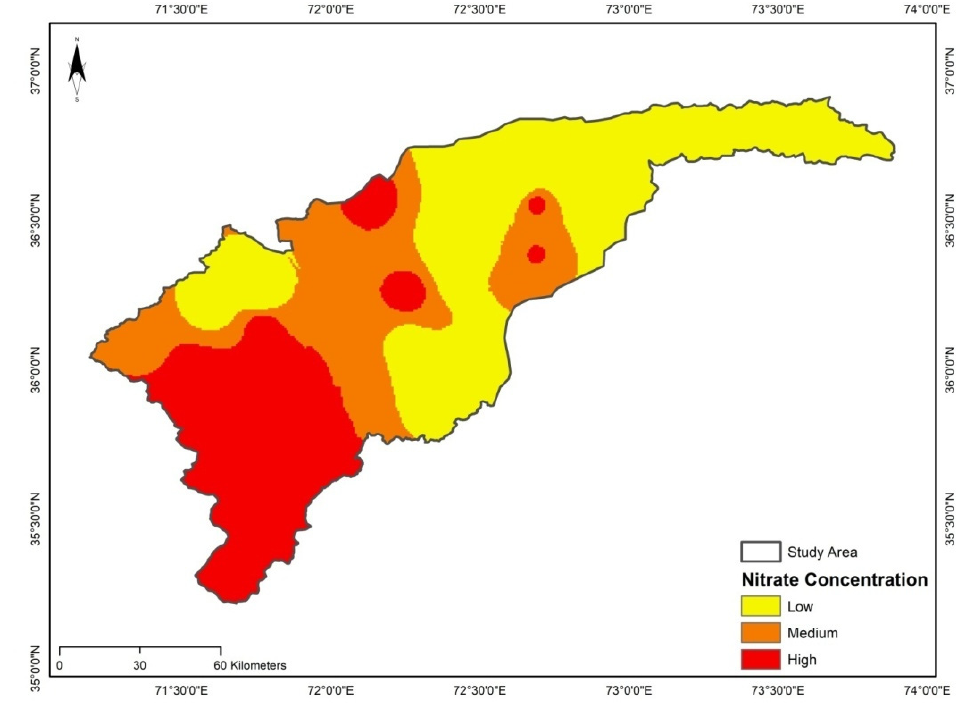
Figure 9. Map showing the concentration of nitrates in the groundwater of Chitral district. A correlation was developed between the values of nitrate concentration, DRASTIC index, and modified DRASTIC index. A relationship is used to examine the association between two computable and continuous variables. An appropriate correlation was made between maximum DRASTICA index values and the highest nitrate concentration values. of nitrate was observed to be − 0.53 and 0.78 respectively. Graphs showed that 53 correlated data pairs were plotted for DI (Figure 10) and MDI (Figure 11) against nitrate concentration. by a positive relationship between MDI and nitrate